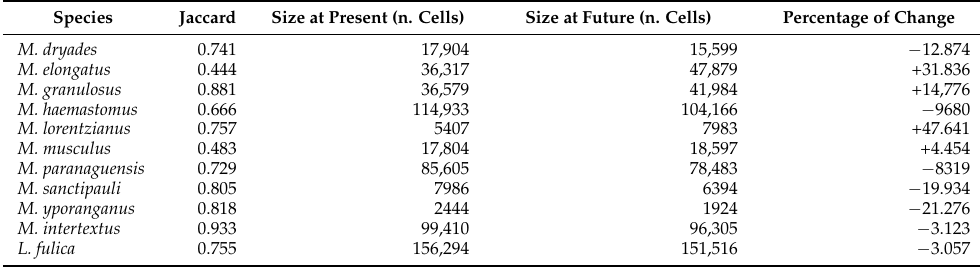
Table 2. Descriptive data of the species distribution models for each